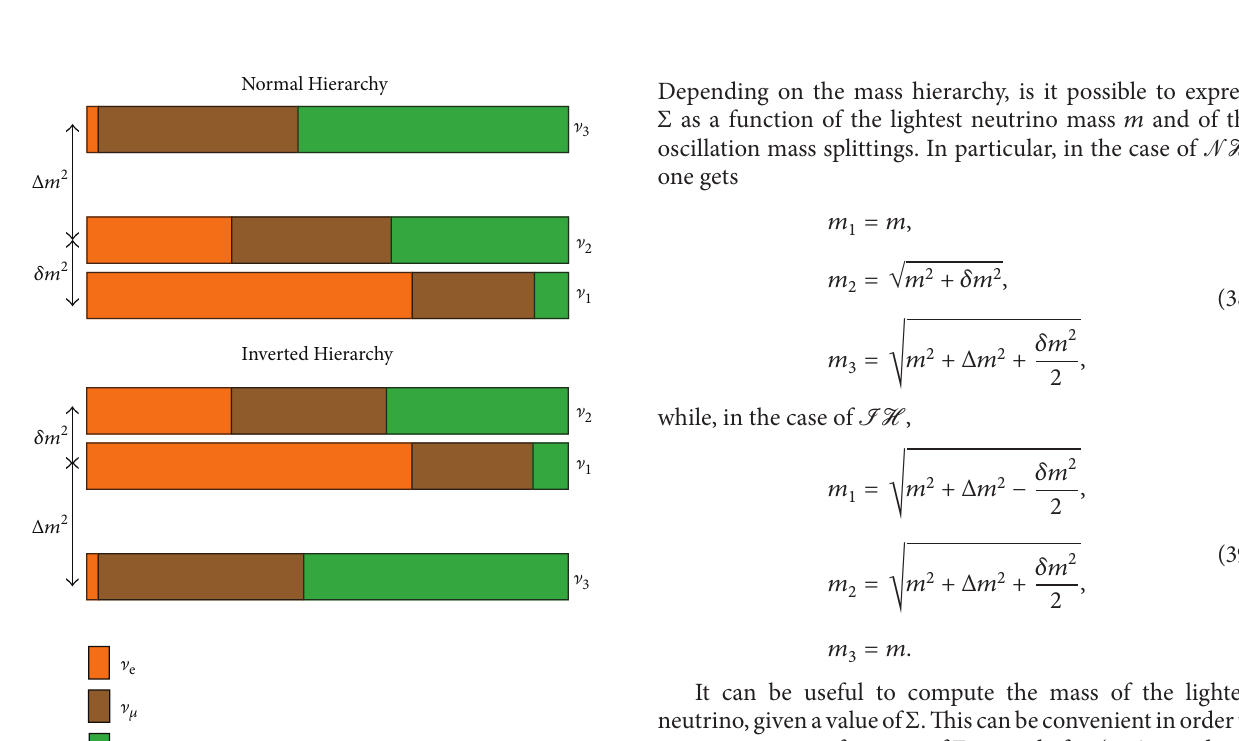
Figure 6: Updated predictions on 𝑚 𝛽𝛽 from oscillations as a function of the lightest neutrino mass (a) and of the cosmological mass (b) in the two cases of NH and IH . The shaded areas correspond to the 3𝜎 regions due to error propagation of the uncertainties on the oscillation parameters. Figure from [124].